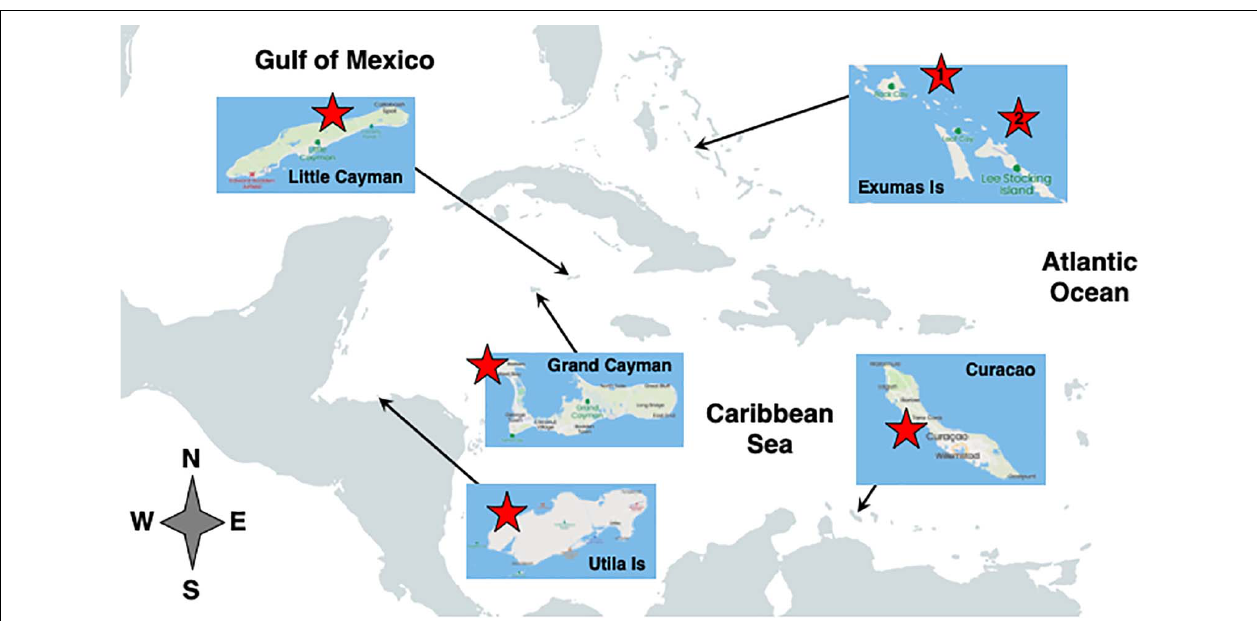
FIGURE 1 | Location of MCE survey sites within the Caribbean Basin. Red stars indicate the approximate location of the survey sites at each location (see text for specific GPS coordinates); Bahamas site 1 = Bock Wall, and site 2 = BA Line, both in the Exumas Island chain. Figure was constructed from maps provided for free distribution by OpenStreetMap